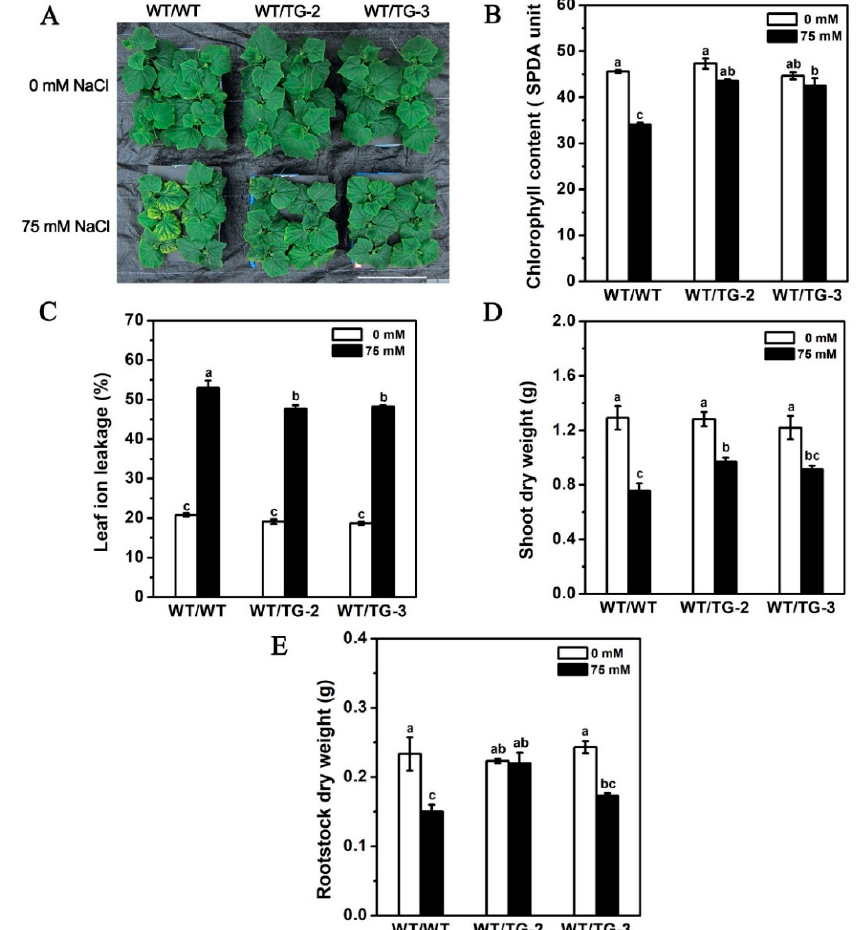
Figure 8. Effect of NaCl treatment on growth in grafted seedlings with transgene CmHKT1;1 cucumber as rootstock. ( A ) Grafted cucumber seedlings were cultivated in hydroponics with 75 mM NaCl for 7 days. ( B ) Chlorophyll content. ( C ) Leaf ion leakage. ( D ) Shoot dry weight. ( E ) Root dry weight. WT, wild type. TG, transgene CmHKT1;1 . WT/WT, WT as the scion and rootstock; WT/TG, WT as